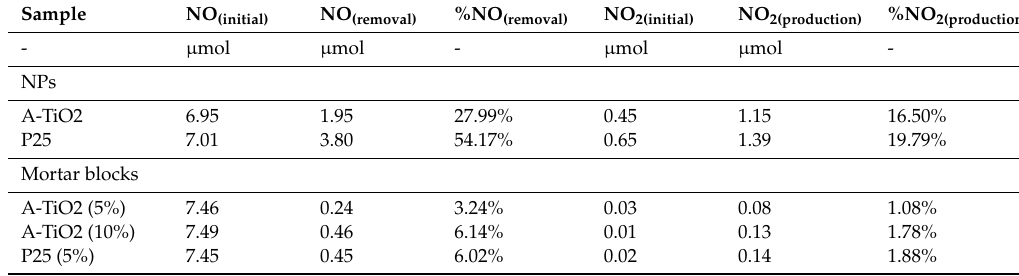
Table 3. Average NO removal and NO 2 generation rates for the prepared samples. Sample